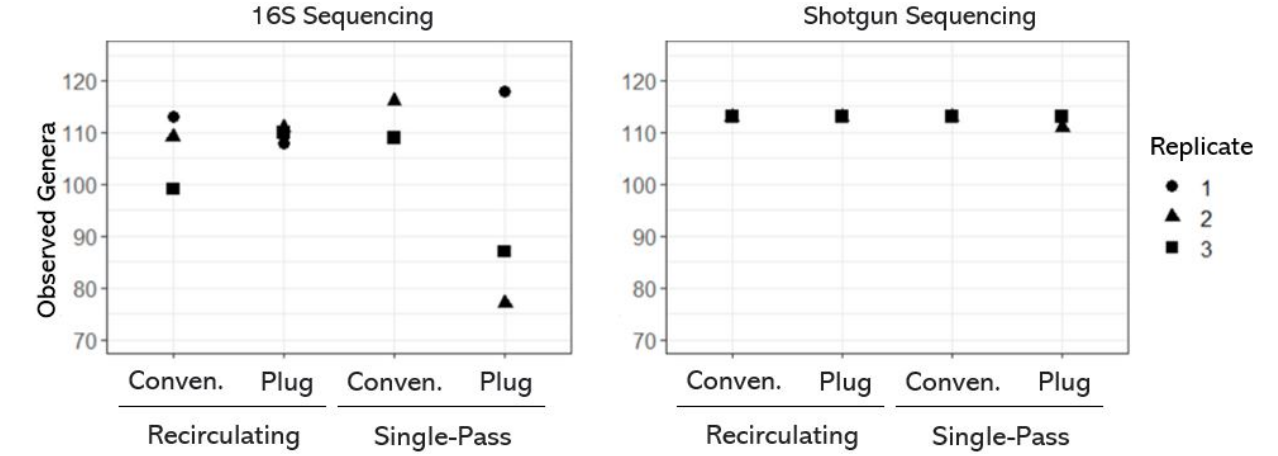
Figure 3. Total taxa above 0.1% relative abundance in each OWTS identified by 16S and shotgun sequencing. Conventional and plug-flow systems are labelled Conven and Plug,